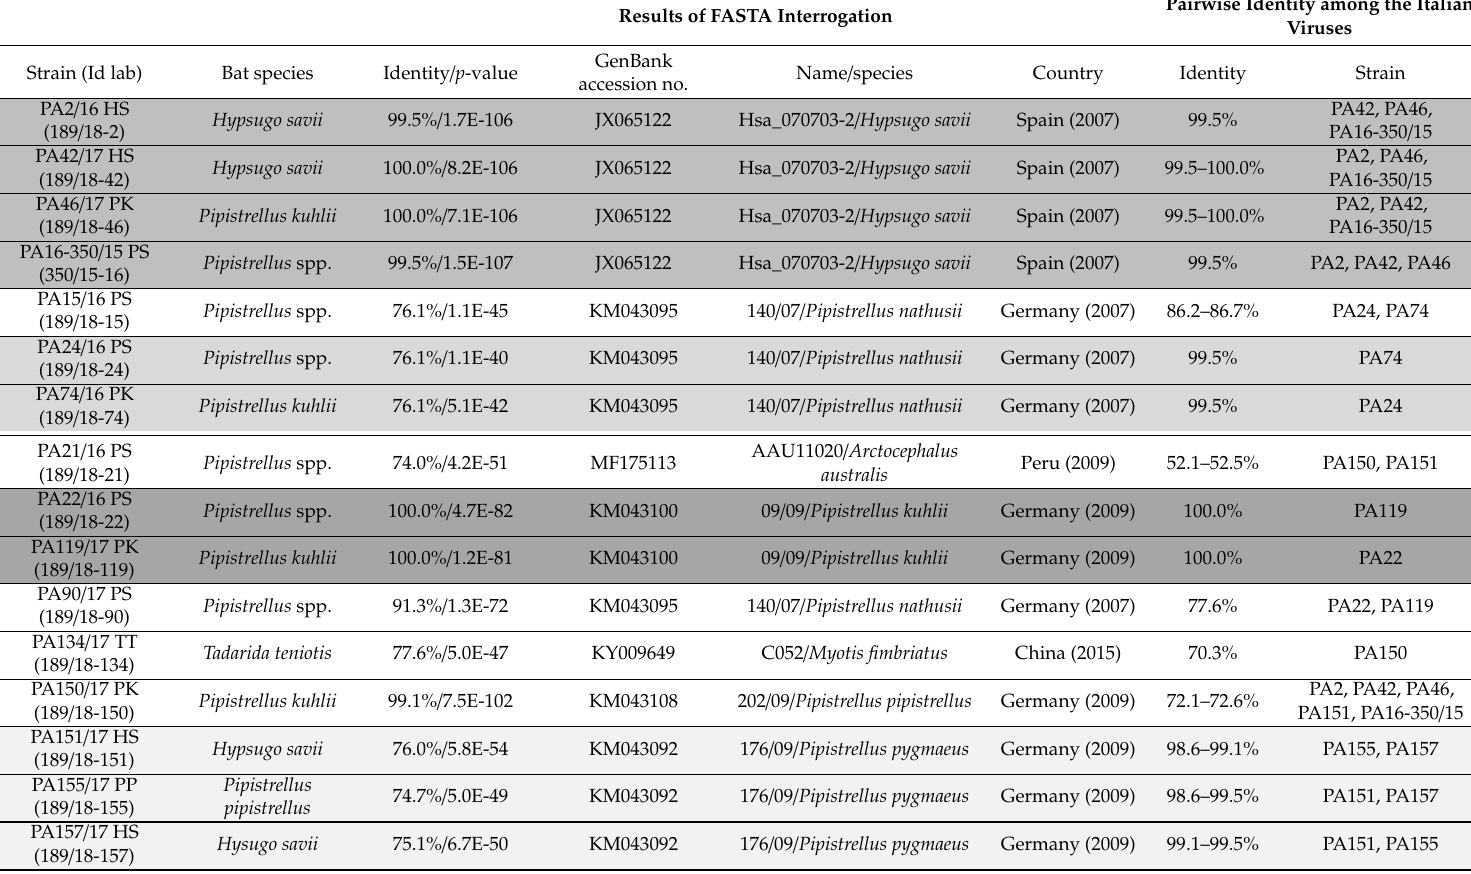
Table 2. BLAST investigation results for the 16 partial polymerase-coding region sequences generated. All the sequences were generated from samples consisted of pools of organs, except for strain PA16-350 / 15 PS that originated from a fecal sample. Gray shades indicate similarities among strains. The nt identity to the closest adenovirus strains is also